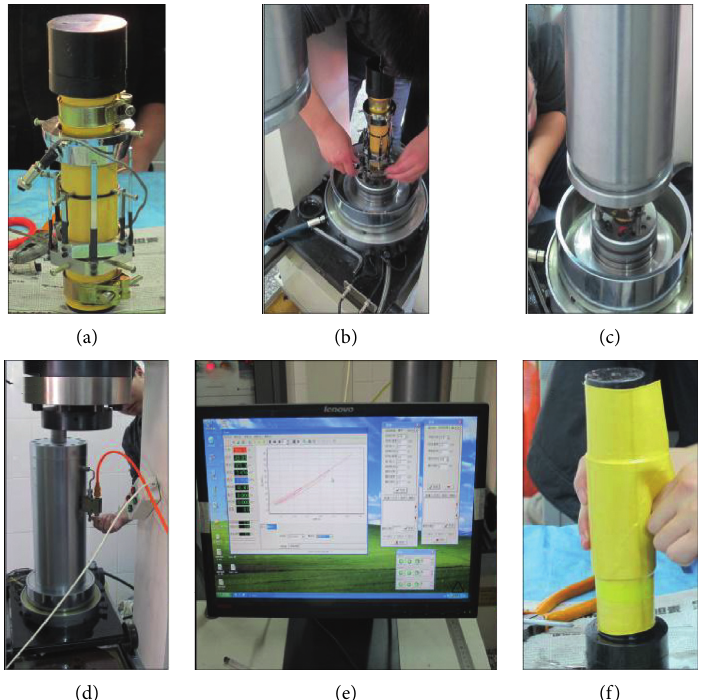
Figure 2: Operation process for the tests. (a) Specimen packaging. (b) Specimen installation. (c) Closed pressure chamber. (d) Oil filled. (e) Control system operation. (f) Specimen demolition.